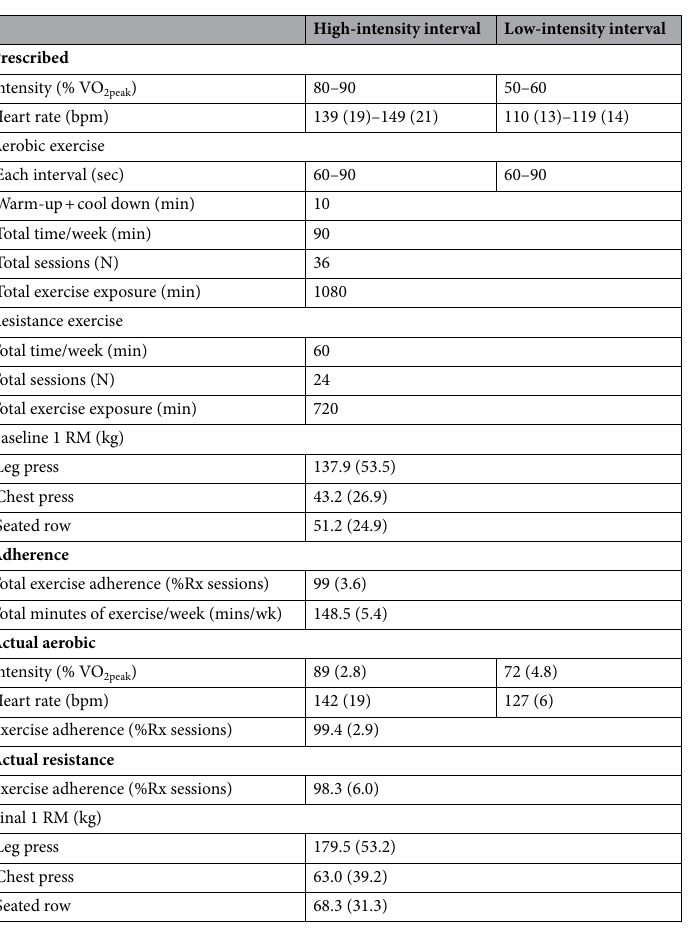
Table 1. Exercise Prescription and results of the intervention. VO 2peak (Aerobic Capacity in mL/kg/min); bpm (beats per minute); min (minutes); Rx (prescription); kg (kilogram); RM (repetition maximum). Data are mean